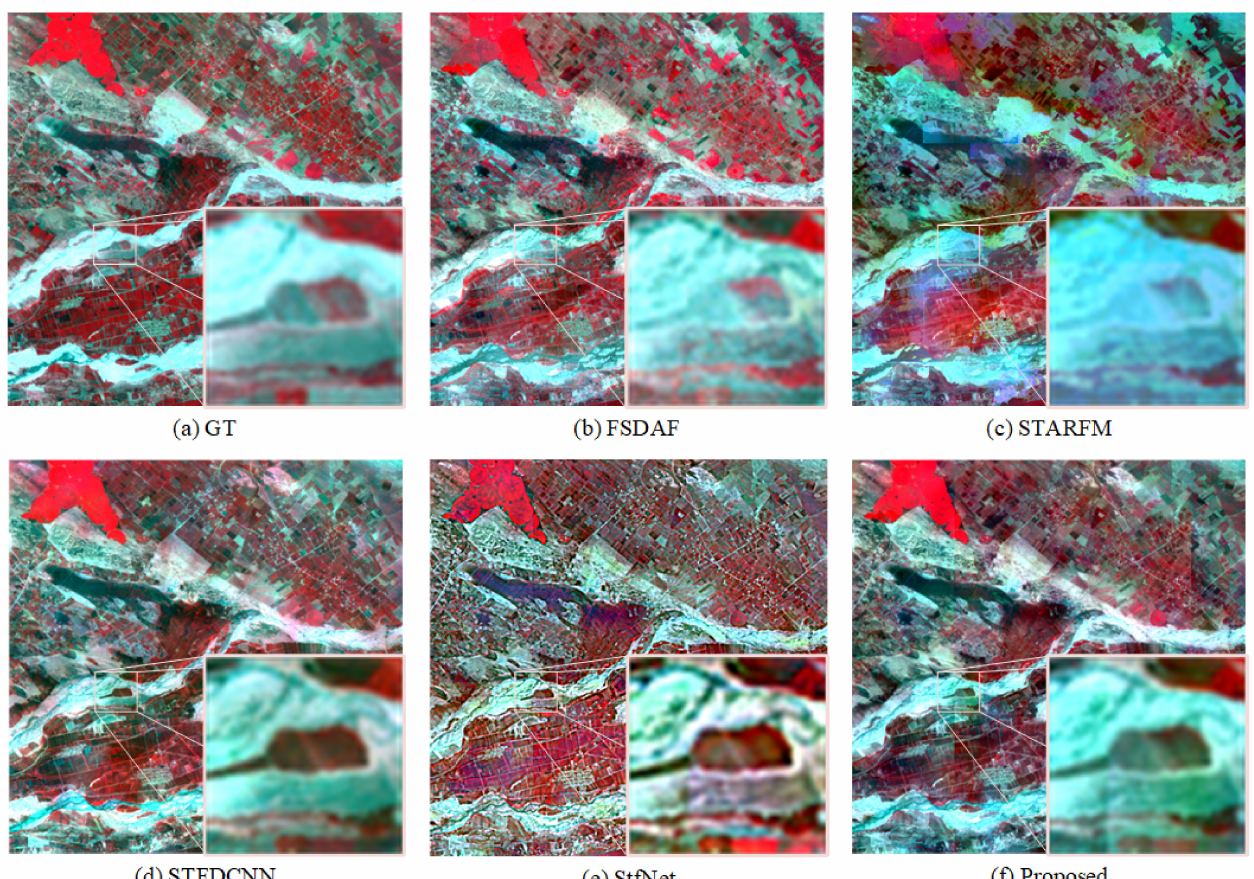
Figure 10. Specific prediction results for the target Landsat image (7 July 2015) in the AHB [32,33] dataset. Additionally, comparison methods include FSDAF [13], STARFM [8], STFDCNN [18], and StfNet [19], which are represented by ( b – e ) in the figure respectively. In addition, ( a ) represents the ground truth (GT) we got, and ( f ) represents the method we